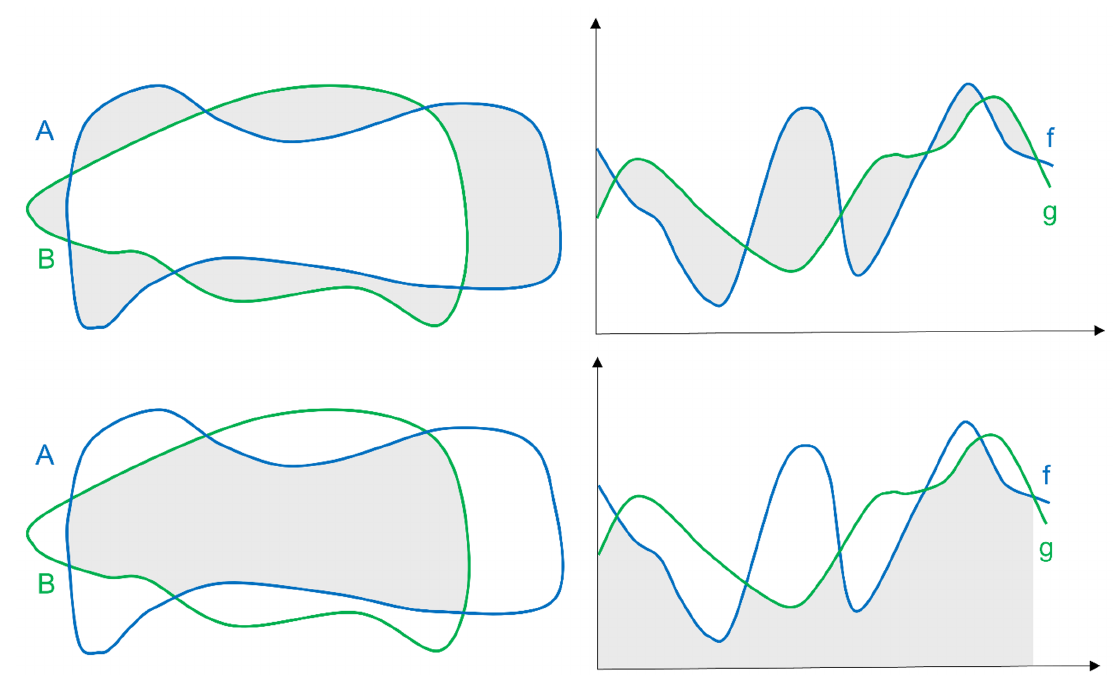
Figure 1. Top—symmetric difference (gray area); bottom—intersection (gray area); left—sets A and B ; right—sub-graphs of f and g (inspired by